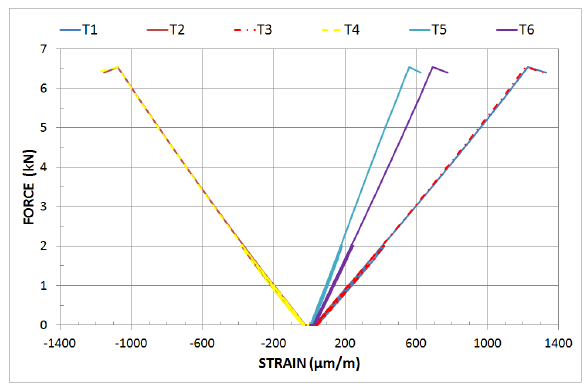
Figure 10. Force-Strain diagram.